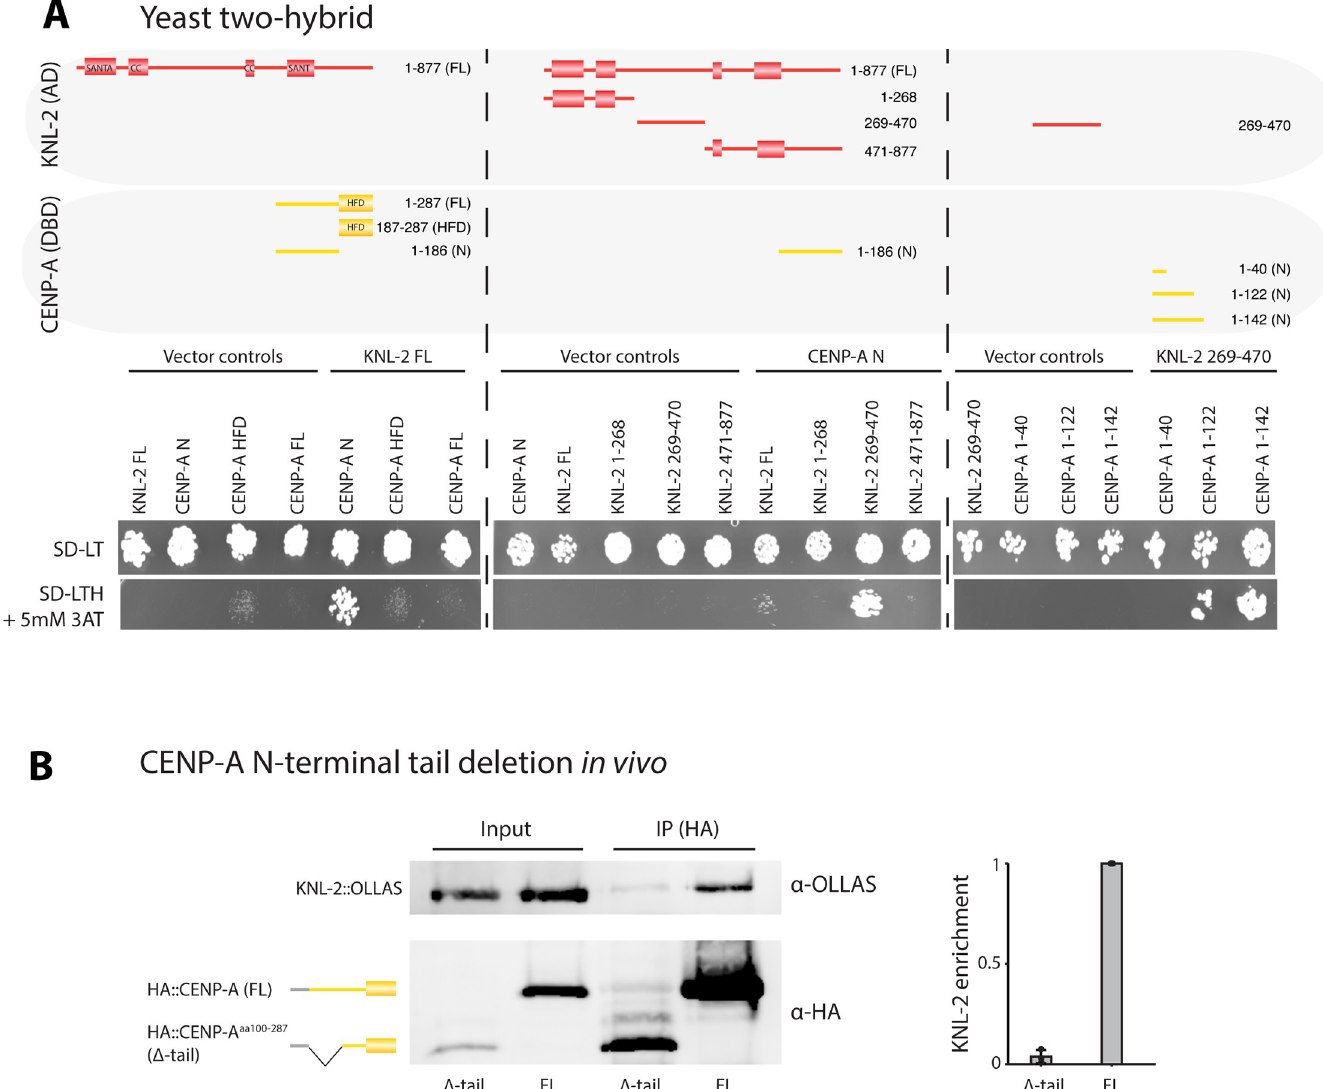
Fig 2. The CENP-A N-terminal tail interacts with the KNL-2 central domain. (A) Yeast two-hybrid analysis of the interaction between CENP-A and KNL-2. Cartoons of the different CENP-A and KNL-2 fragments used (top), showing the annotated SANTA, SANT/Myb, and CC domains in KNL-2 and HFD in CENP-A. The interaction between the constructs were determined by assaying growth of yeast cells on selective medium (SD-LTH, containing 5 mM 3AT). Vector-only constructs and nonselective plates (SD-LT) were used as negative and positive controls for growth, respectively. Left, full-length KNL-2 interaction with different parts of CENP-A. Center, interaction of the CENP-A N-terminal tail with different regions of KNL-2. Right, interaction of different CENP-A N-terminal tail fragments with the KNL-2 central region. (B) Co-IP experiments with KNL-2 and CENP-A FL or CENP-A aa100-287 ( Δ -tail). In cartoons, CENP-A is shown in yellow and HA in gray. Representative western blot showing IPs of HA-tagged CENP-A FL, or Δ -tail from embryonic extracts. HA-tagged constructs were IPed and detected using an anti-HA antibody. OLLAS-tagged KNL-2 was detected using an anti-OLLAS antibody in input and IP samples. The bar graph shows a quantification of relative KNL-2 enrichment, which was determined as the IP ratio of KNL-2/CENP-A divided by the input ratio of KNL-2/CENP-A, with the interaction for CENP-A FL set to 1 in each experiment. N = 3 independent IP/western blotting experiments. The data underlying all the graphs can be found in S1 Data. CC, coiled-coil; CENP-A, centromere protein A; Co-IP, co-immunoprecipitation; FL, full-length; HFD, histone fold domain. CENP-A (referred to as FL) is linked to a transgene expressing pharyngeal GFP, thus allowing us to visually distinguish worms heterozygous and homozygous for CENP-A Δ -tail. C . elegans populations mostly consist of hermaphrodites that produce both oocytes and sperm and self- fertilize to give rise to the next generation, although males that only produce sperm and rely